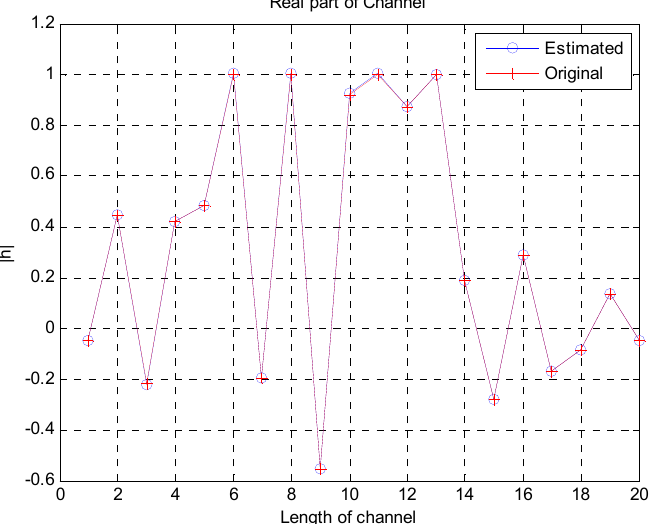
Figure 2. Amplitude estimation of the real part of channel taps.